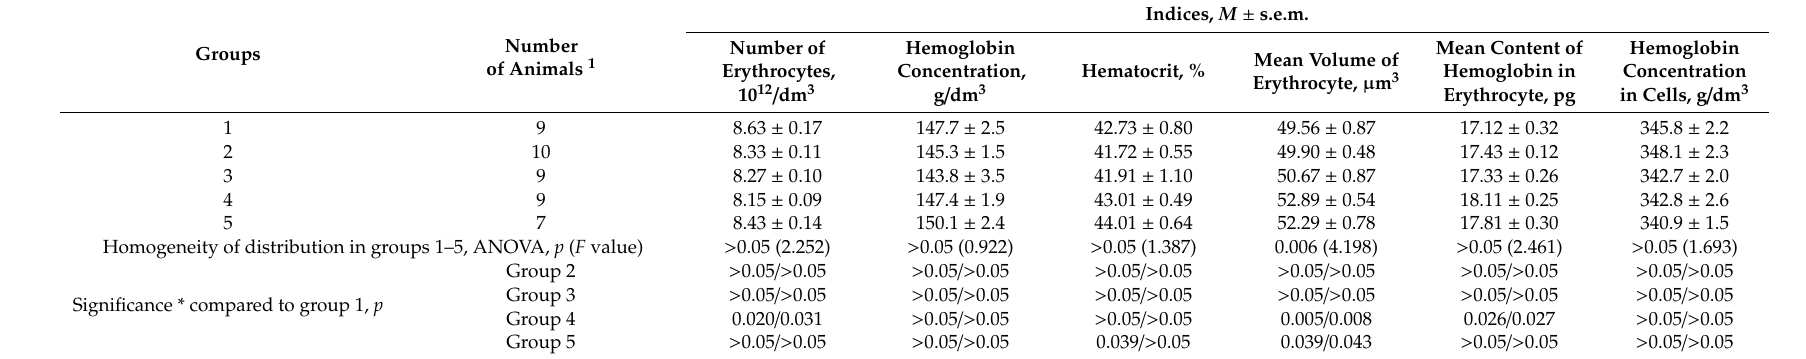
Table 2. Erythrocyte indices in groups 1–5 on the 93rd day of the experiment.